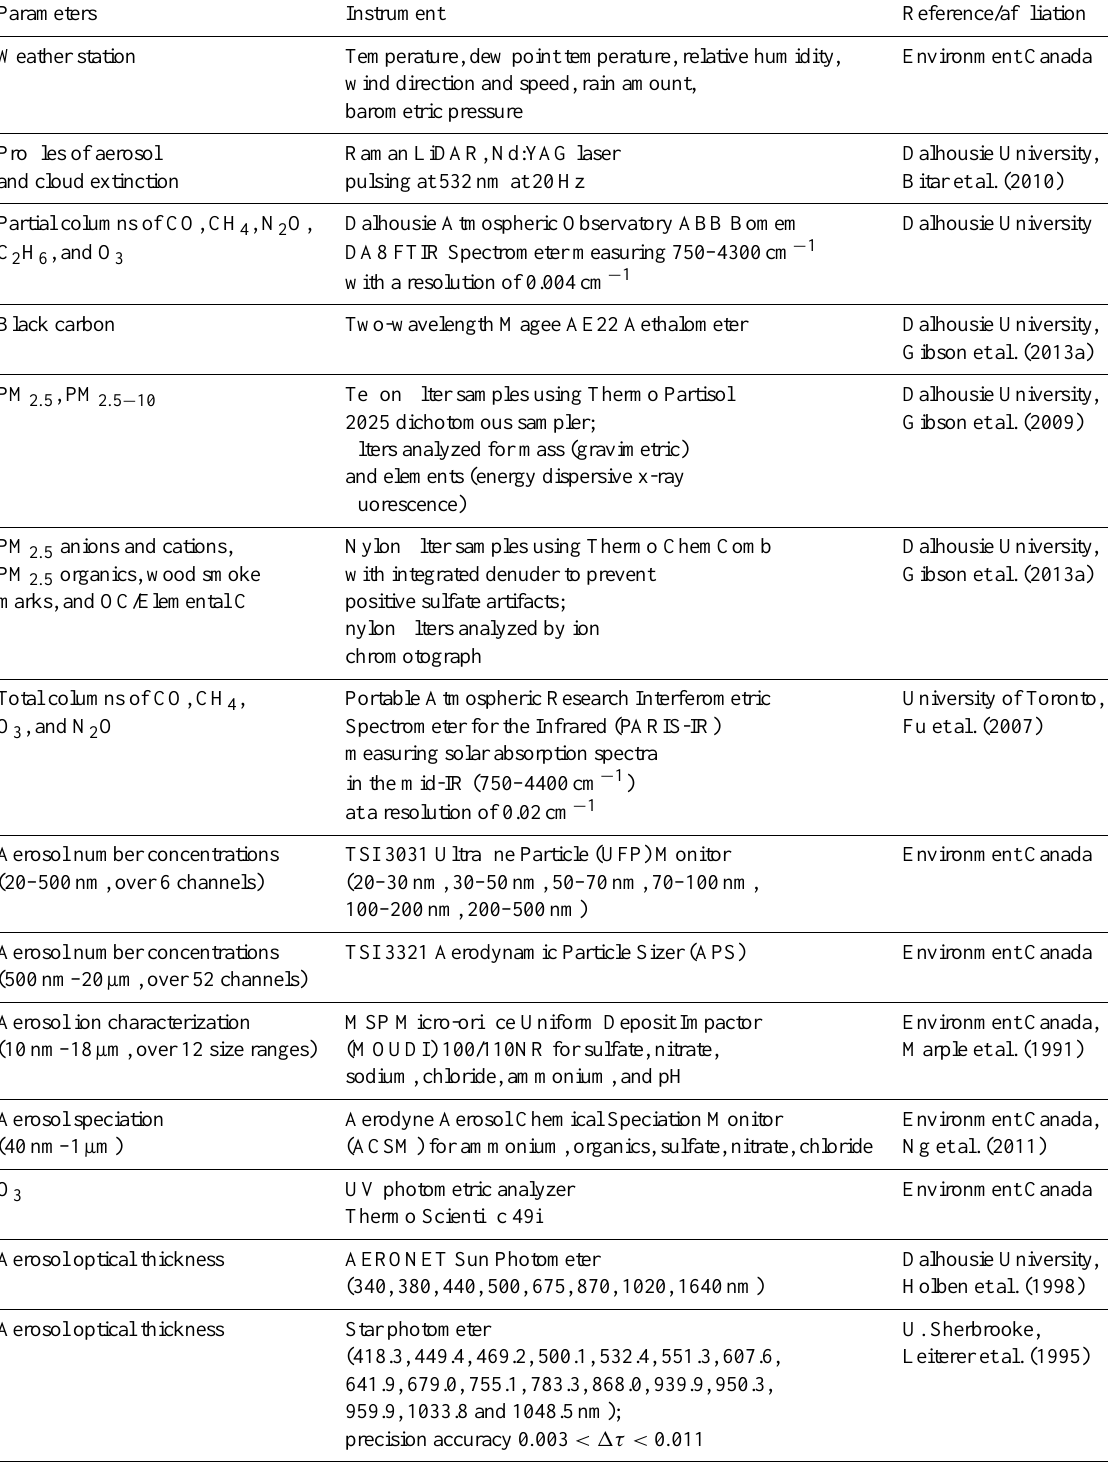
Table 4. Ground-based measurements at the Dalhousie Ground Station during